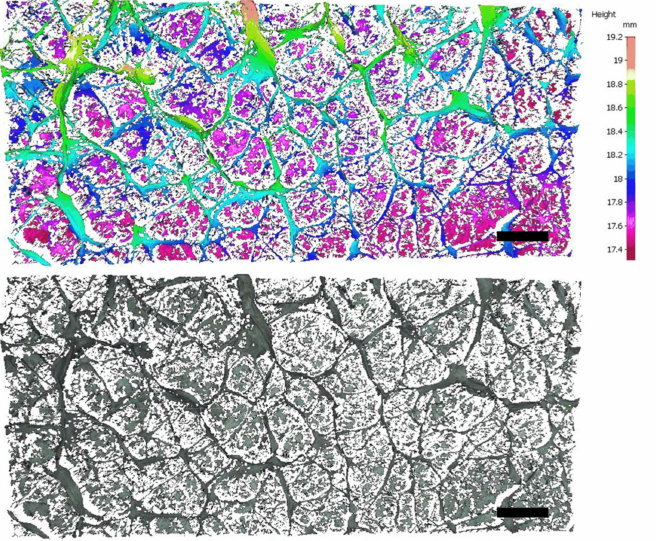
Figure 2. Surface profiles of uneven honeycomb films. Scale bars are 2